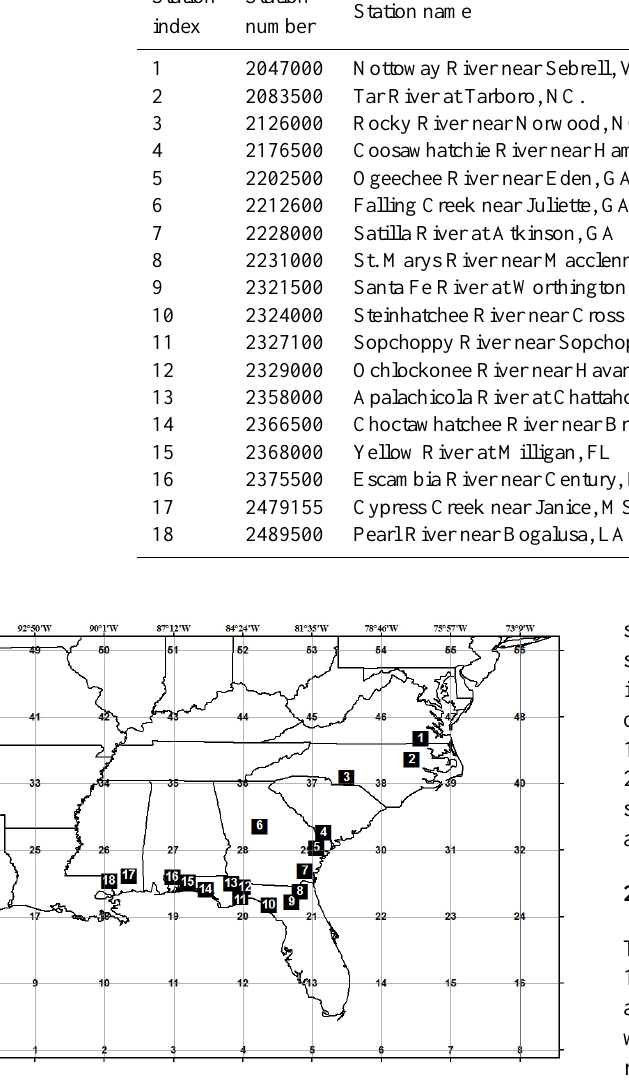
Figure 1: Location of the 18 Hydro-Climatic Data Network (HCDN) stations along with the Fig. 1. Location of the 18 Hydro-Climatic Data Network (HCDN) considered grid points of precipitation forecasts over the Southeast United States (SEUS). stations along with the considered grid points of precipitation fore- casts over the Southeast United States